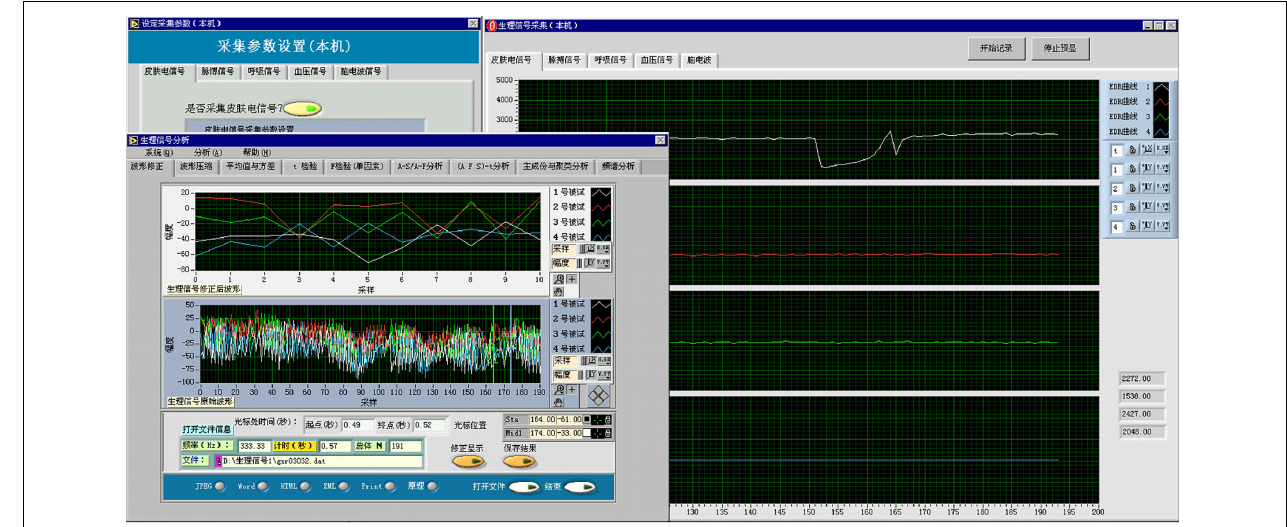
FIGURE 3 | Physiological signal acquisition and processing program (software runtime interface).